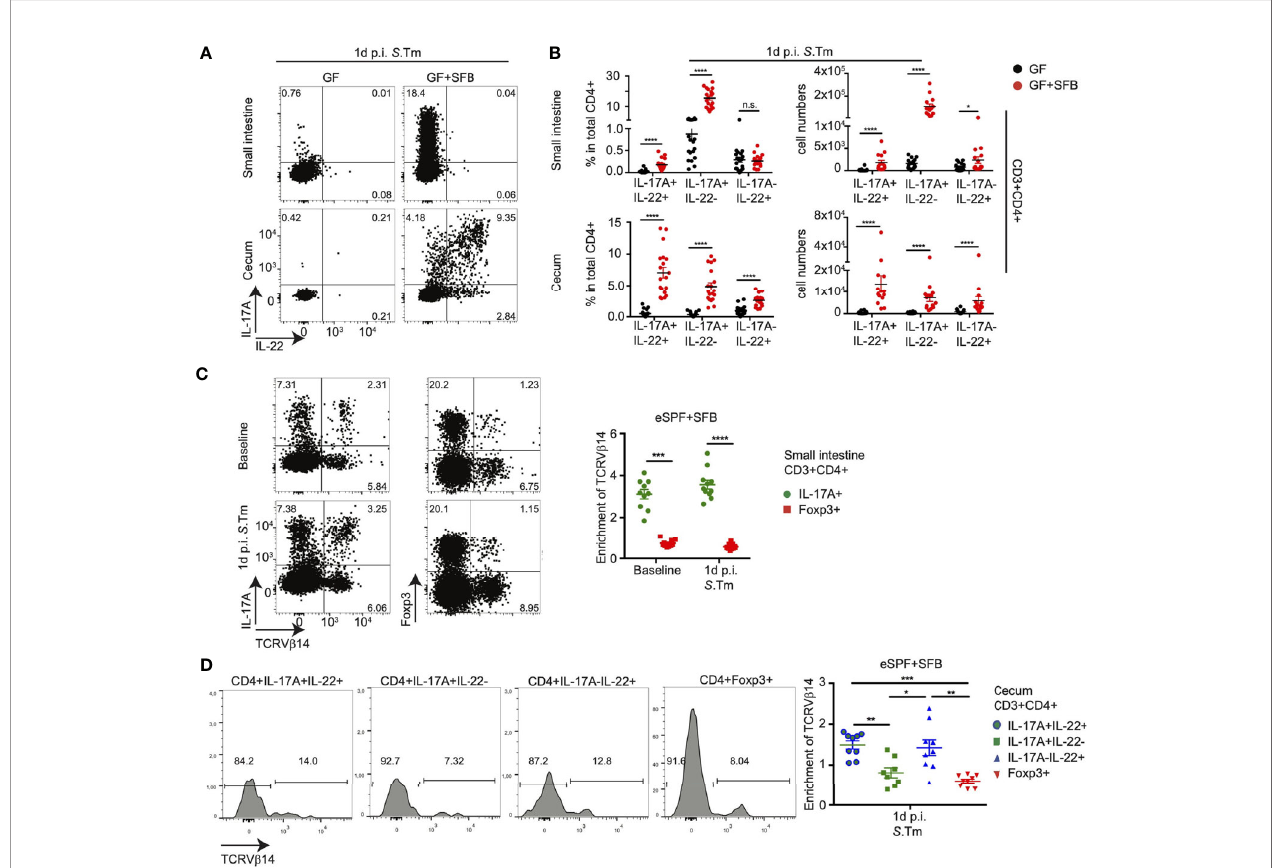
FIGURE 3 | Anti-bacterial IL-17A and IL-22 responses by CD4+ T cells are SFB speci fi c. (A, B) LPL were isolated 1d post S . tm. infection from the small intestine and cecum of IL-17A GFP IL-22 BFP FoxP3 RFP mice under GF or GF+SFB conditions. Representative FACS plots (A) and percentages and absolute numbers (B) of CD3+CD4+ cells expressing IL-17A and IL-22 without ex vivo restimulation. (C) CD3+CD4+ T cells from small intestinal LPL from eSPF+SFB mice were analyzed for V b 14 expression in IL-17A+ and Foxp3+ cells. Left, representative FACS plots and right, speci fi c enrichment of V b 14 TCRs in CD4 T cells expressing IL-17A and Foxp3 in the absence of ex vivo restimulation. (D) CD3+CD4+ T cells from cecal LPL from eSPF+SFB mice after 1d S . tm . infection were analyzed for V b 14 expression in IL-17A+ and/or IL-22+ and Foxp3+ cells. Left, representative FACS plots and right, speci fi c enrichment of V b 14 TCRs in CD4 T cells expressing IL-17A and/or IL-22 and Foxp3 in the absence of ex vivo restimulation. Data represent n = 9 – 16 mice/group as mean ± SEM from at least two independent experiments. P-values indicated represent an unpaired Student ’ s t test *p < 0,05; **p < 0,01; ***p < 0,001; ****p < 0,0001; n.s., not signi fi cant. See also Supplementary Figure S3